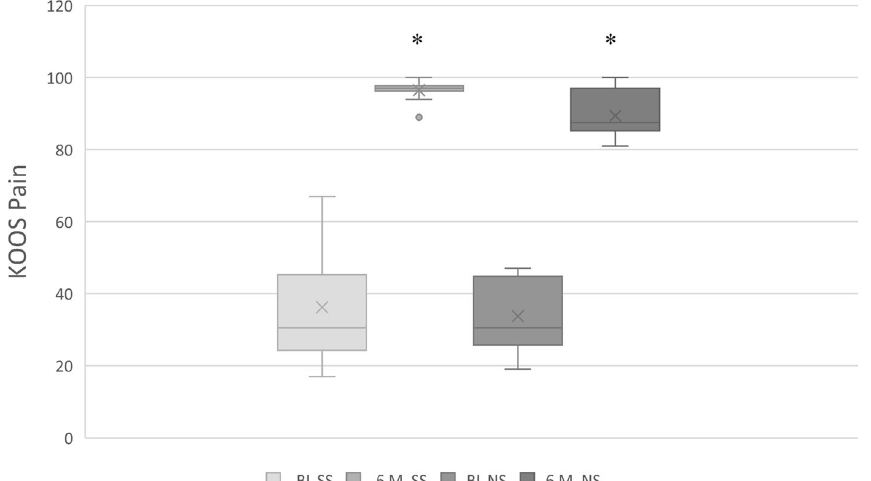
Fig. 2 Box and whisker plot showing Knee Injury and Osteoarthritis Outcome Score (KOOS) pain subtype in patients at 6 months following total knee arthroplasty. BL SS, baseline short stature; 6 M SS, postoperative 6 months short stature; BL NS, baseline normal stature; 6 M NS, postoperative 6 months normal stature. The line inside the box signifies the median, the box signifies the interquartile range (IQR), and the whiskers describe the range. * p <